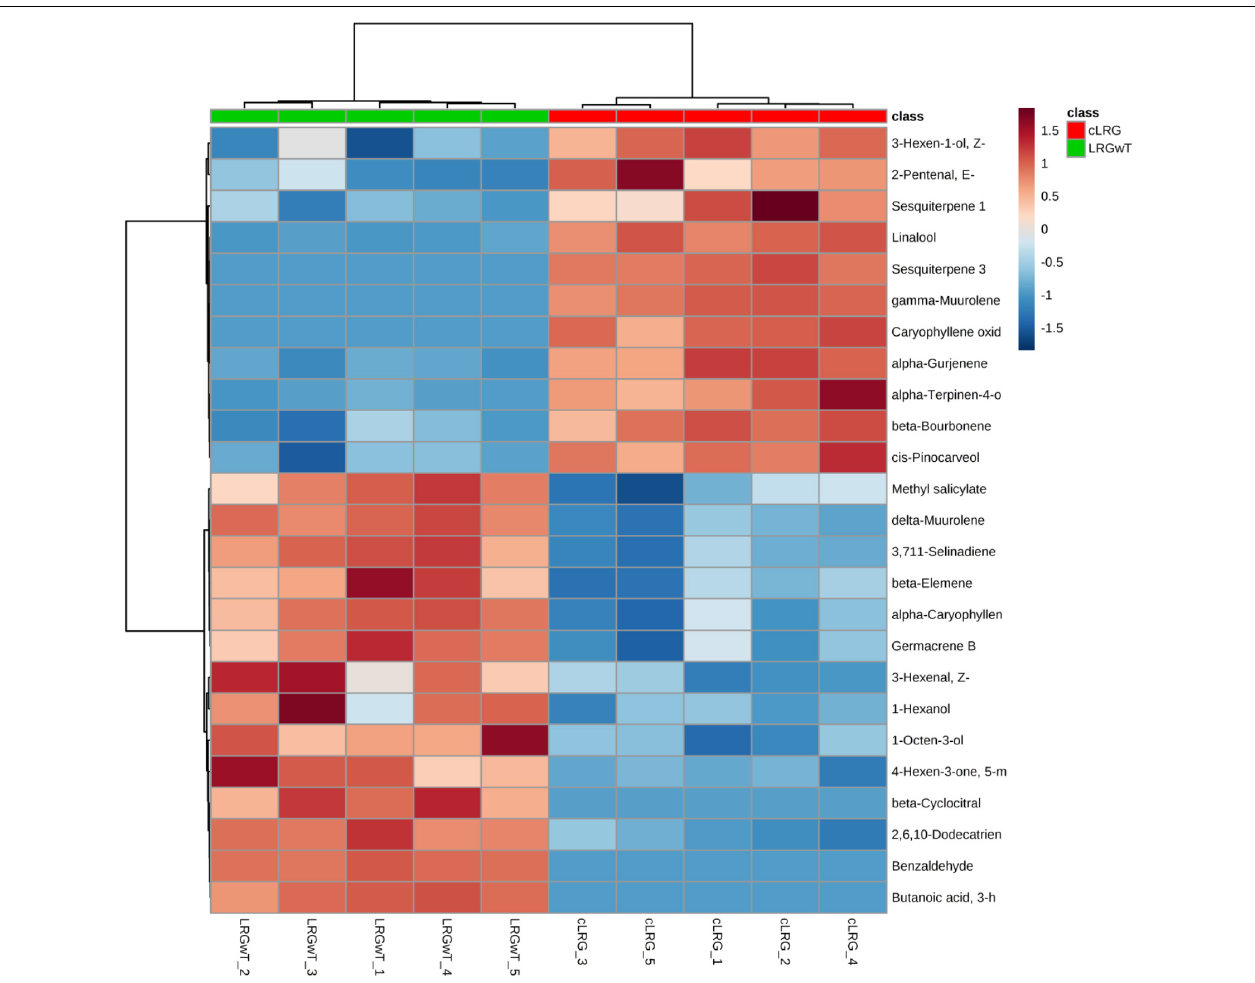
FIGURE 8 | Heat map of galls. The heat maps were constructed based on the 25 most discriminating compounds. Compounds identified by HS-SPME-GC/MS. Color key indicates metabolite expression value, blue: Lowest, red: